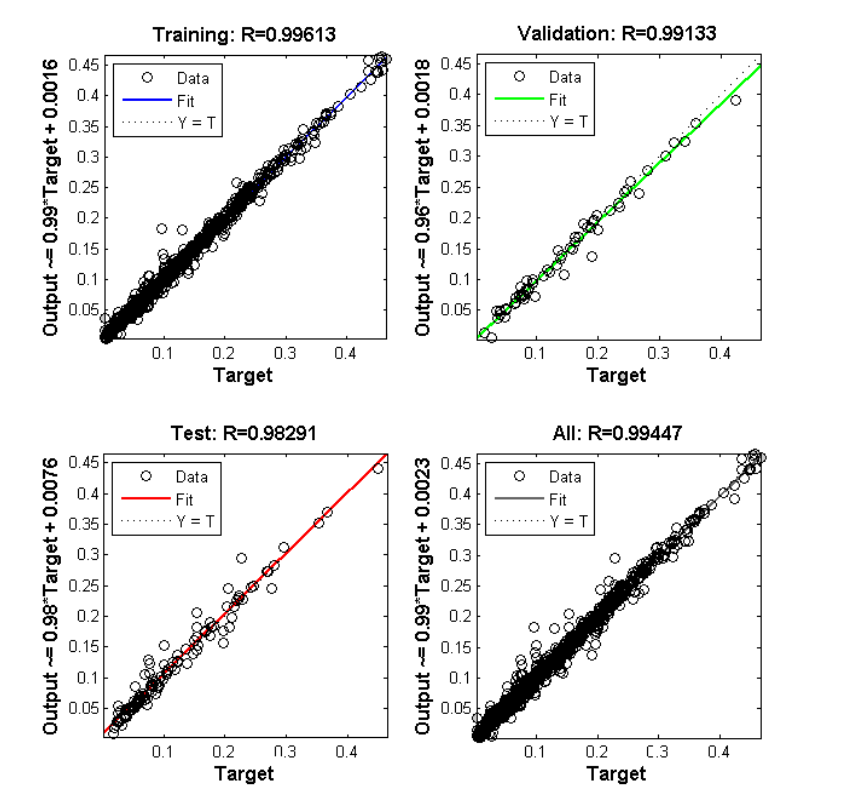
Figure 5. Predicted results from network versus target Data for CO2 Injection